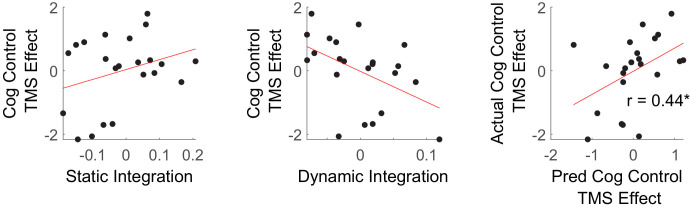
Integration predicts transcranial magnetic stimulation (TMS) effects with reduced smoothing.Details are identical to Figure 9B.